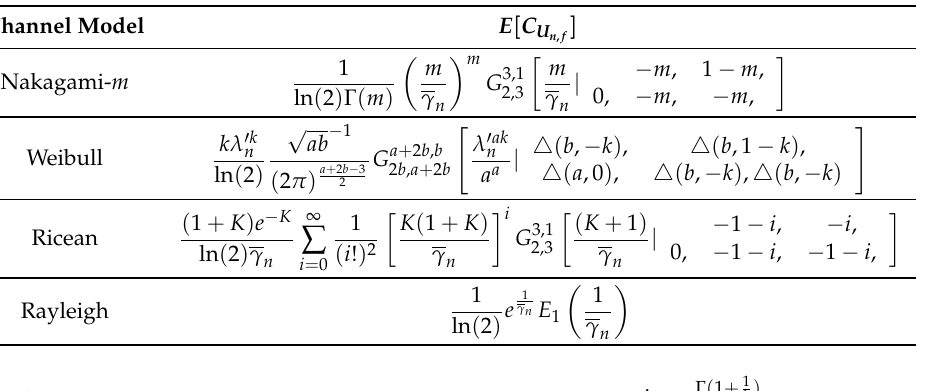
Table 3. The ergodic full-time access capacity of user n for different fading